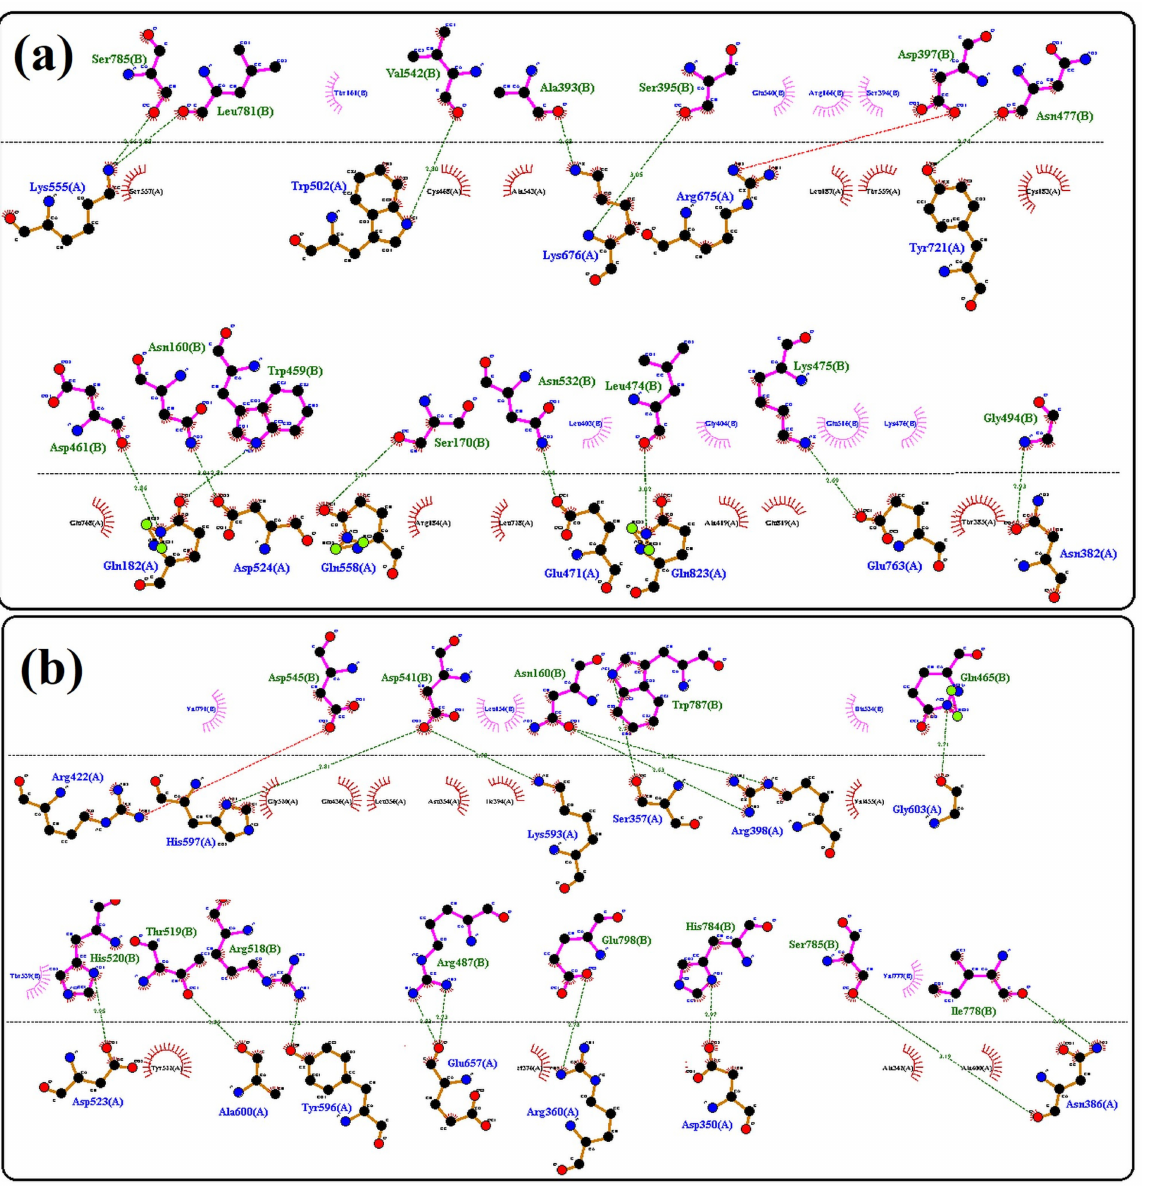
Figure 4. Molecular docking of the candidate proteins with the identified interactor: ( a ) docking of wild-type and ( b ) mutant ARMC3